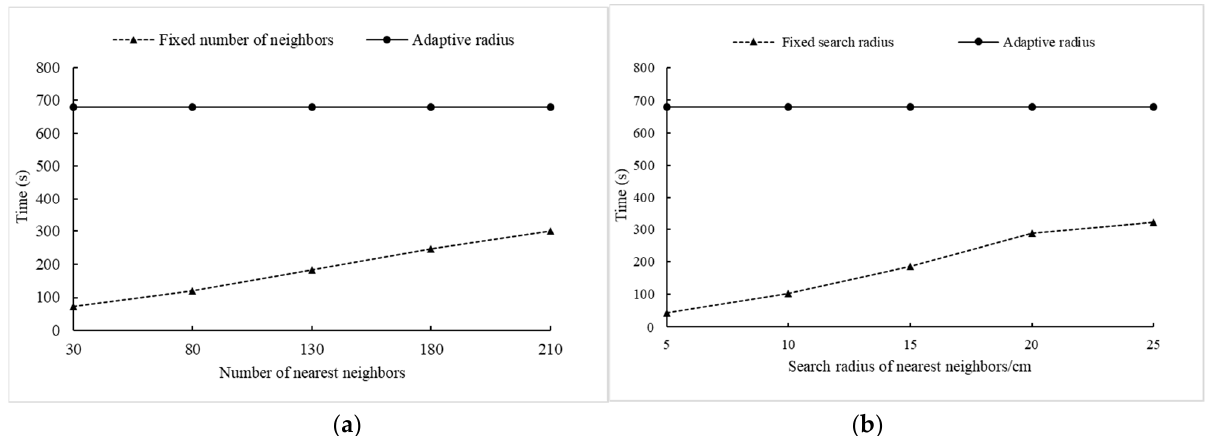
Figure 6. Comparison of feature calculation time between adaptive radius search and traditional KNN search methods. ( a ) Fixed number of neighbors (Method I) vs. adaptive radius search (Method III), ( b ) Fixed search radius (Method II) vs. adaptive radius search (Method III).